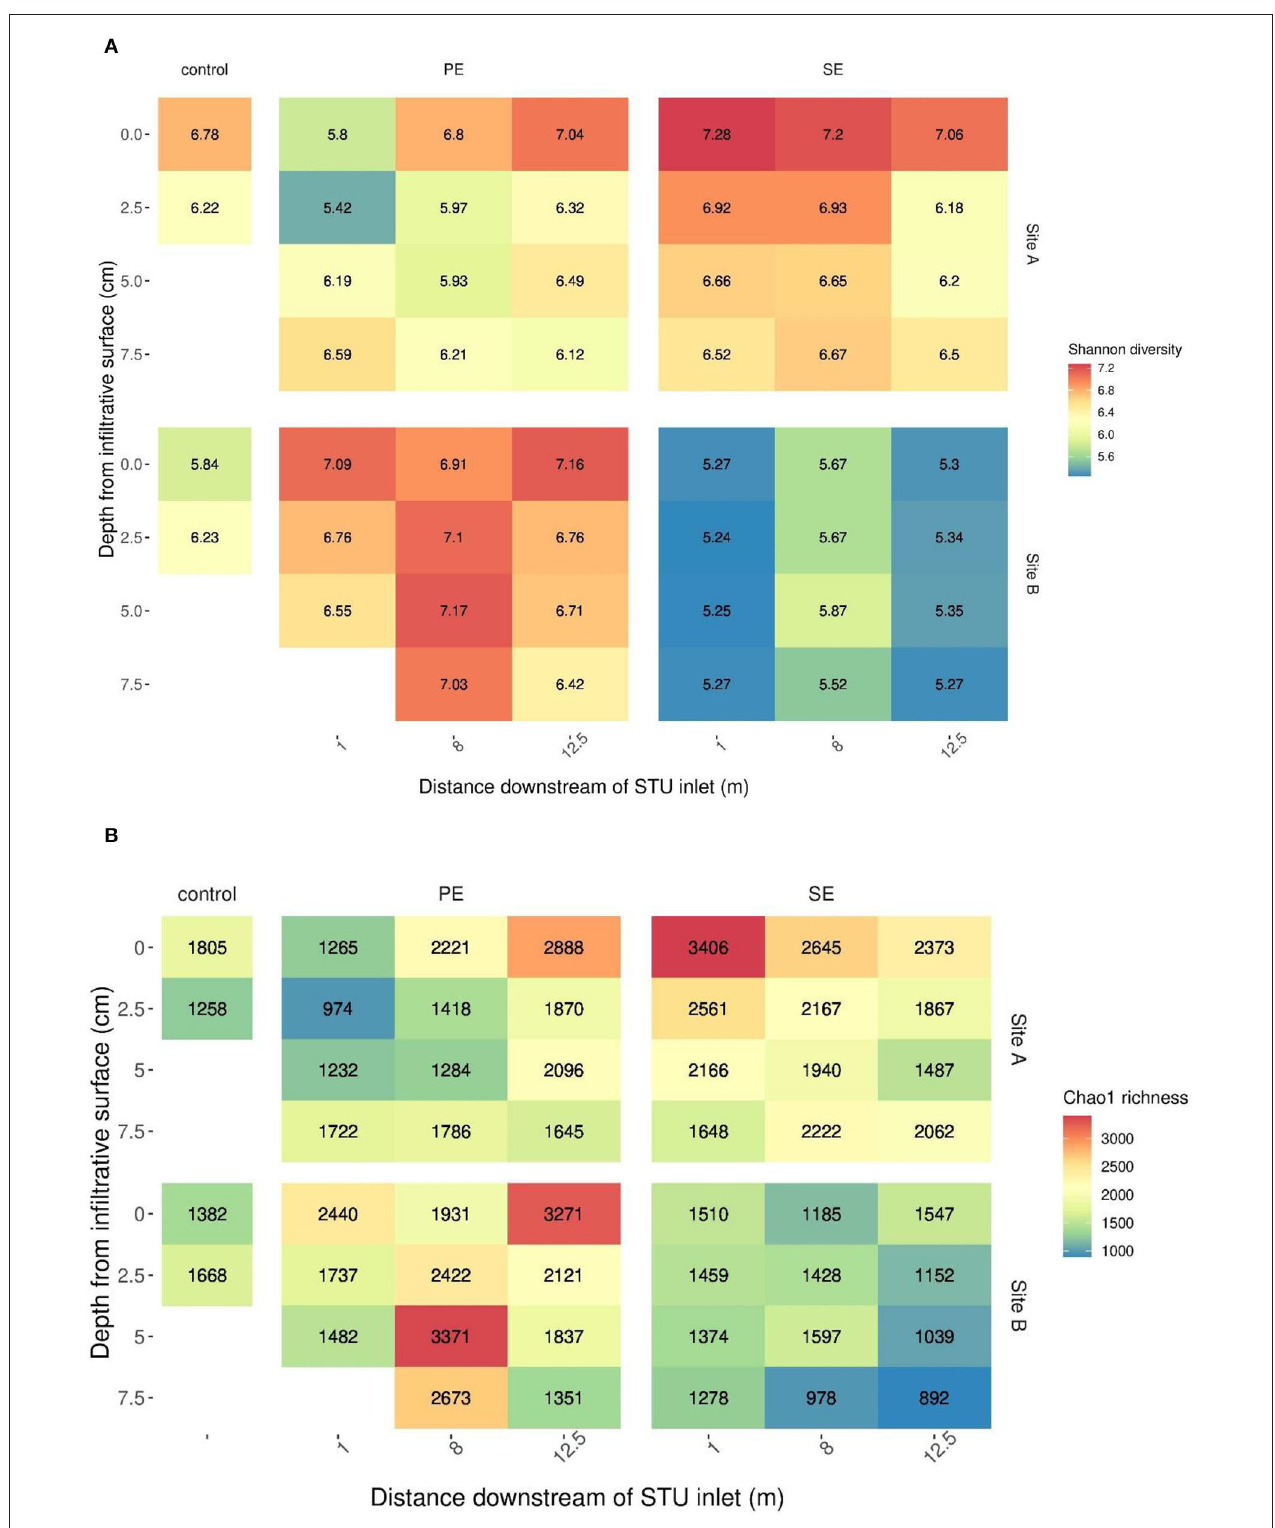
FIGURE 5 | The Shannon diversity (A) and Chao1 richness (B) across the distance and depth of the sites’ primary (PE) and secondary effluent (SE) STUs.